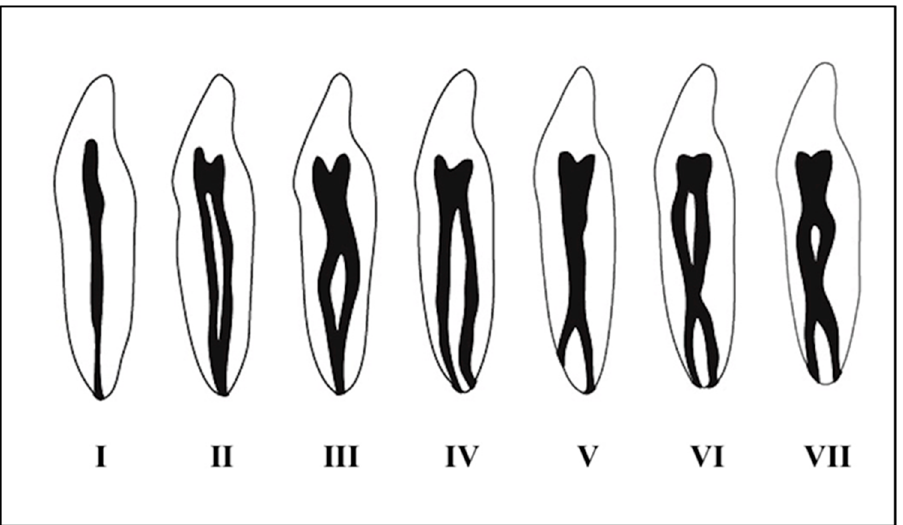
Figure 1. Vertucci’s configuration adapted to the permanent mandibular incisor.